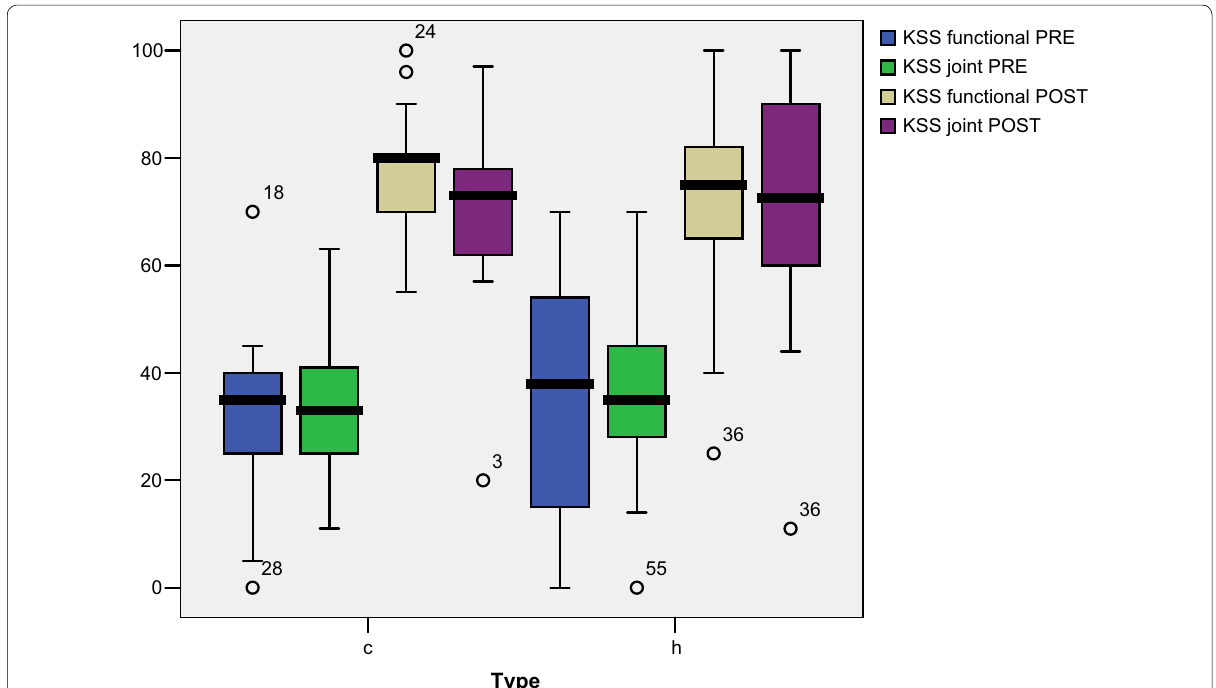
Fig. 2 Group comparison [cemented (c) and hybrid (h) ] of the pre‑ to postoperative variation in the AKSS index